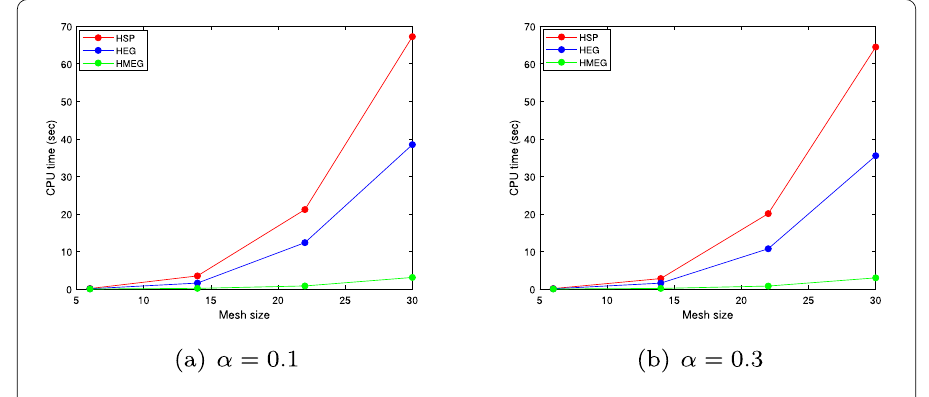
Figure 3 The CPU time plot of the HSP, HEG and HMEG methods for Example 5.1